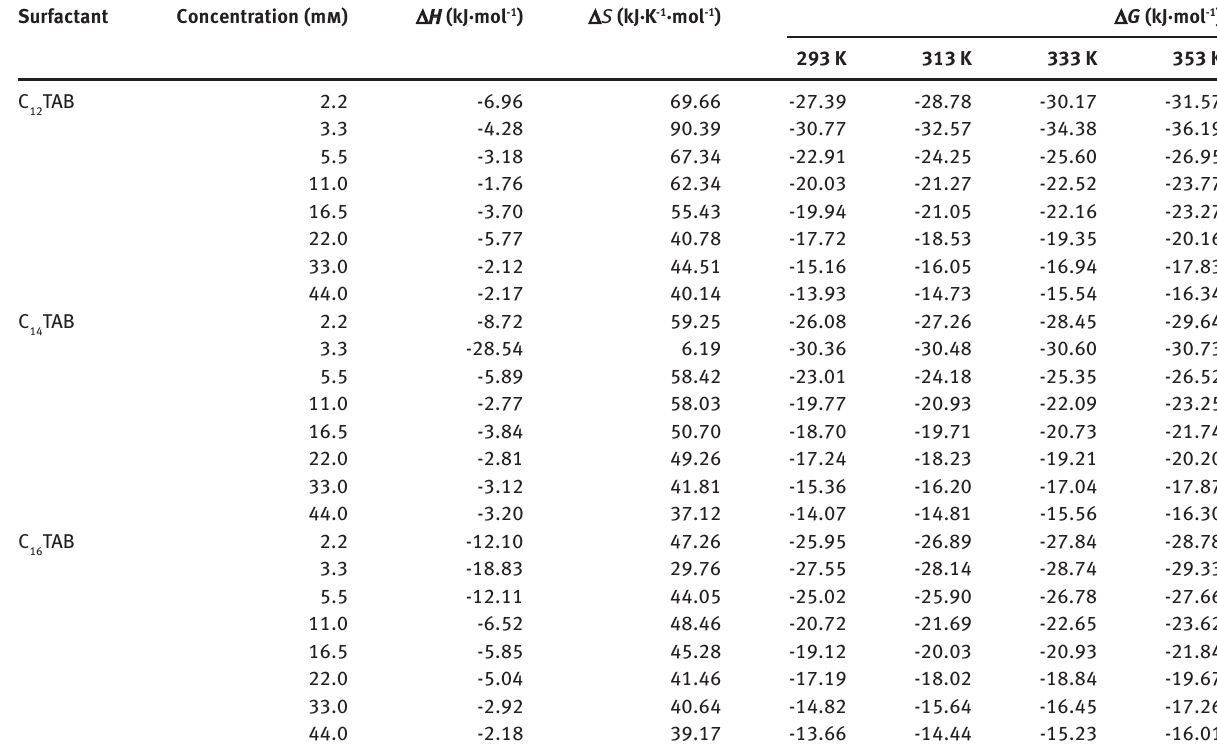
Table 2 Thermodynamic parameters for the absorption of the surfactants on GO in various concentrations and at different temperatures. Surfactant